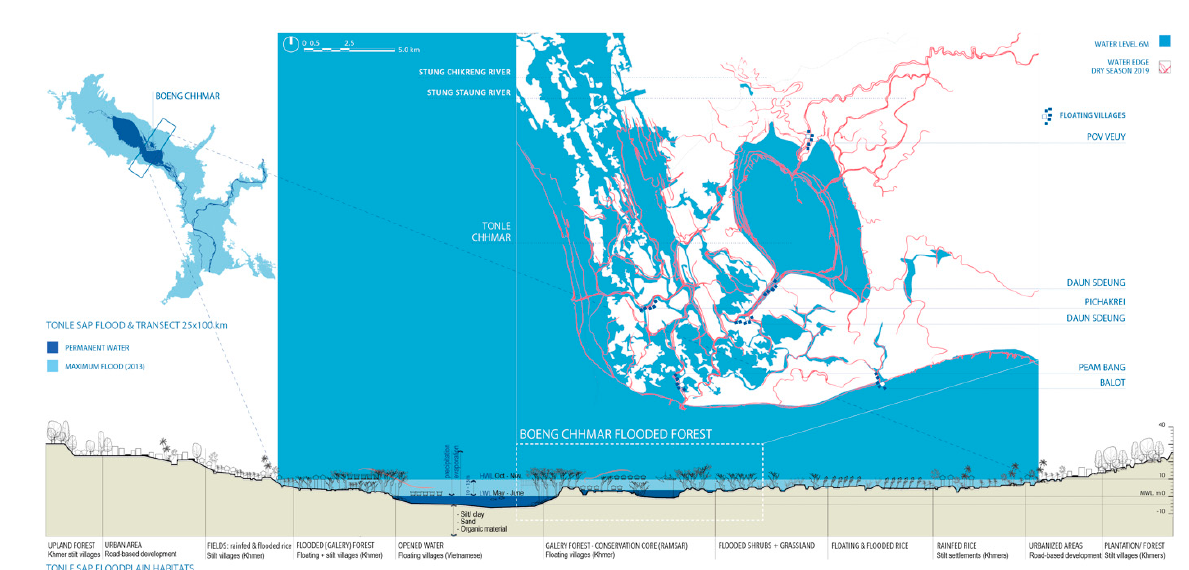
Figure 1. Boeng Chhmar forest and floating villages the Tonle Sap Lake and floodplain. The lake habitats are determined by the great seasonal flood − pulse. The transition of habitats follows the dynamic inundated topography from the floodplain to the opened water. Most of the area in Boeng Chhmar is inundated during the flooding season when only high tree canopies, flood − resilient plants and floating species can be seen. (Linh Vu, 2022, with GIS Cambodia open source, Google Earth, ecological and hydrological studies of the Tonle Sap).